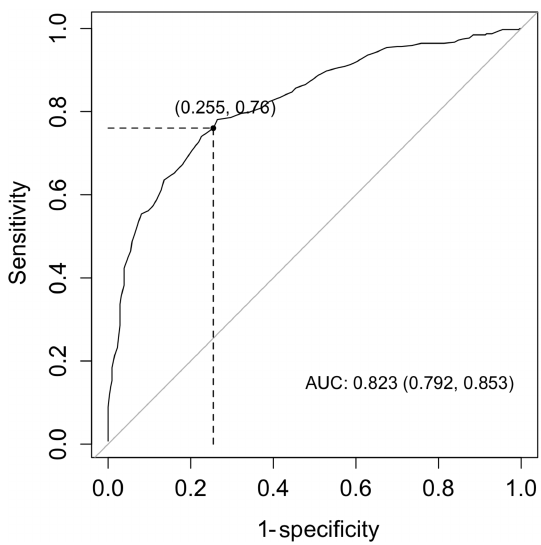
Figure 4. Receiver operating curve (ROC) for an independent test- ing dataset of small and large fires that occurred from 2015 to 2016. Sensitivity and (1-specificity) values are shown for the point where large fire probability values > 0 . 47 are classified as a large fire and values < 0 . 47 are classified as a small fire, since this value was found to simultaneously maximize sensitivity and